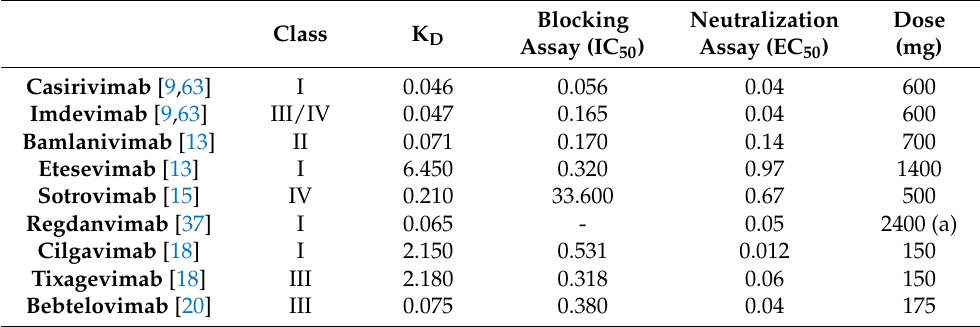
Table 3. Class and functional parameters of anti-COVID-19 therapeutic antibodies. All measurements are reported in nanomolar